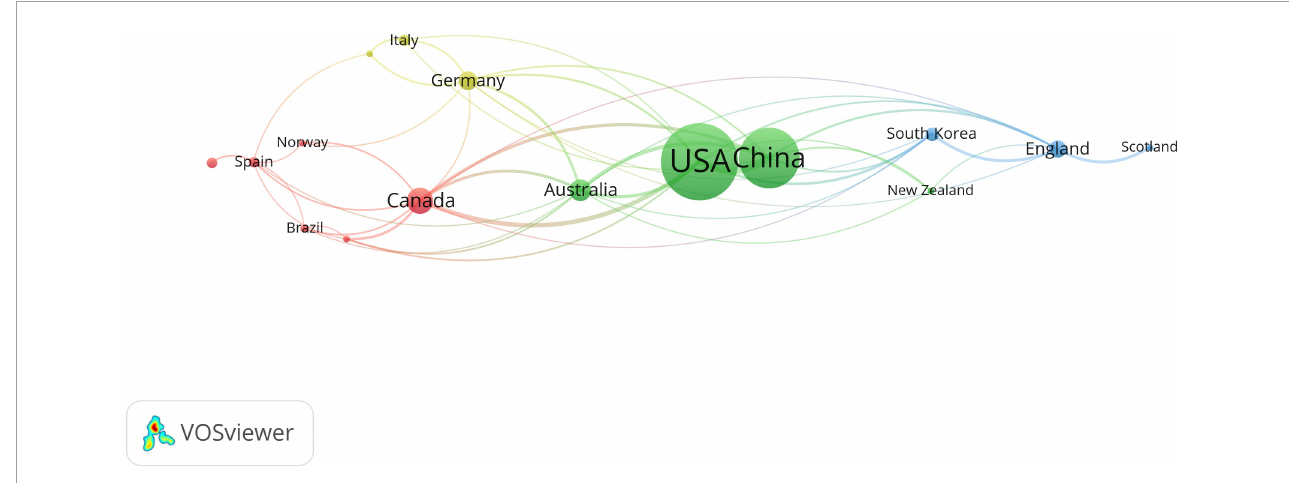
FIGURE4 Map of countries with publications in traditional Chinese exercises for musculoskeletal disorders research from 2000 to